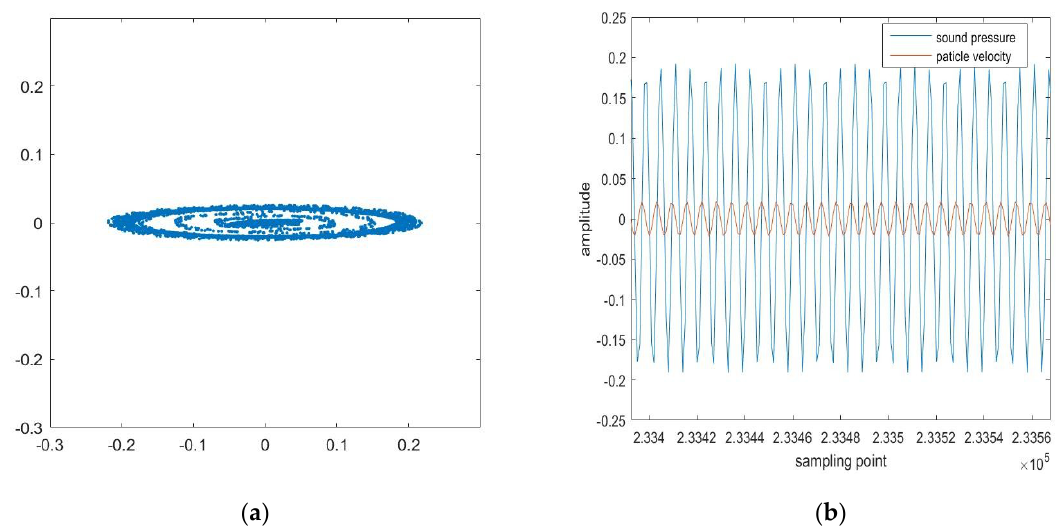
Figure 9. Descriptions of the complex signal PV: ( a ) Scatter diagram via “real-imaginary” plot; ( b ) Time domain wave of the real part and imaginary part of PV respectively.